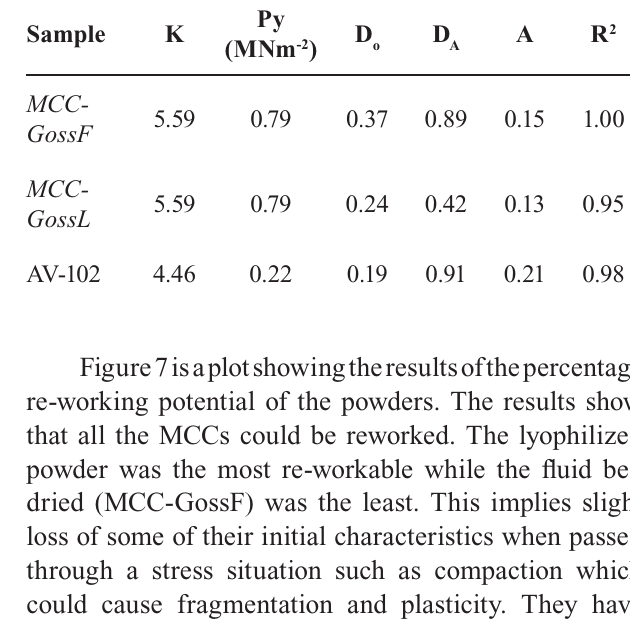
TABLE IV - Parameters of Heckel plot